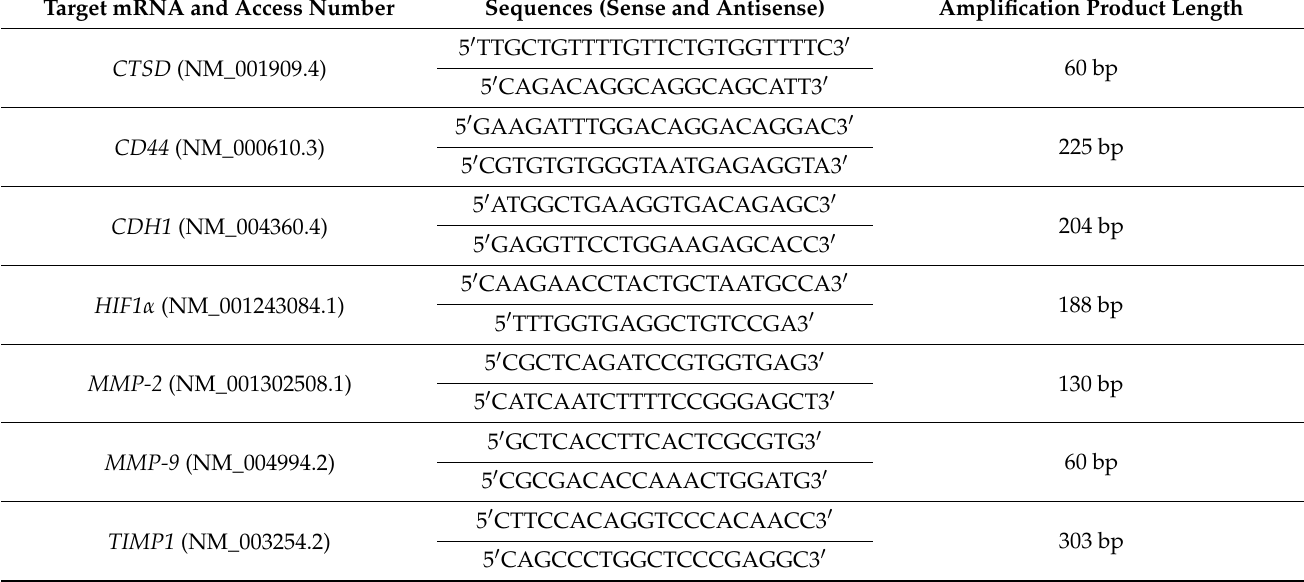
Table 2. The sequences of primers used in the real-time RT-PCR analyses. Target mRNA and Access